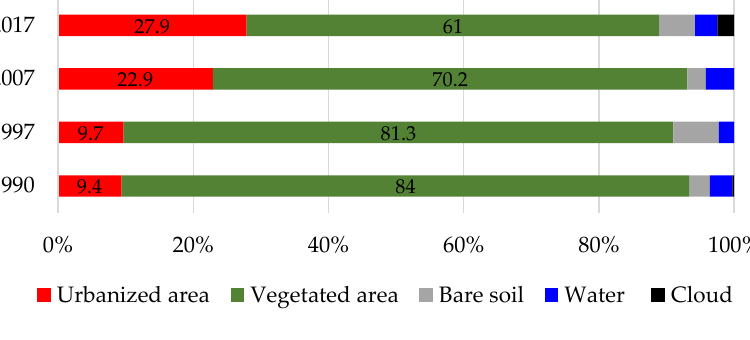
Figure 5. Diagram of LCZ proportion in 1900 – 2017.